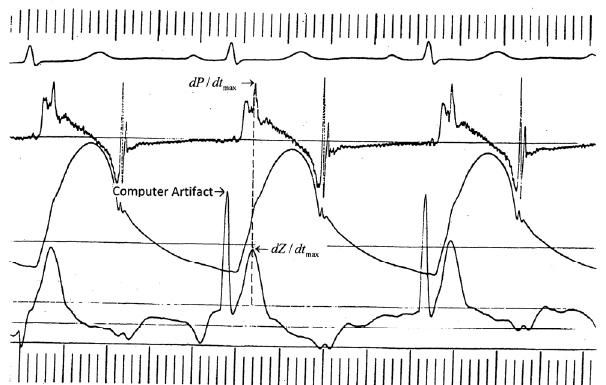
Fig. 7. Ascending aortic dP/dt, ascending aortic pressure P, and dZ/dt from a human. Note that dZ/dt max peaks precisely with ascending aortic dP/dt max . Note computer artifact. Courtesy of Kirk L. Peterson, M.D.; From